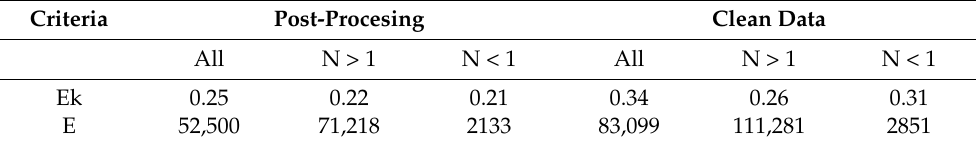
Table 5. Criteria results over all